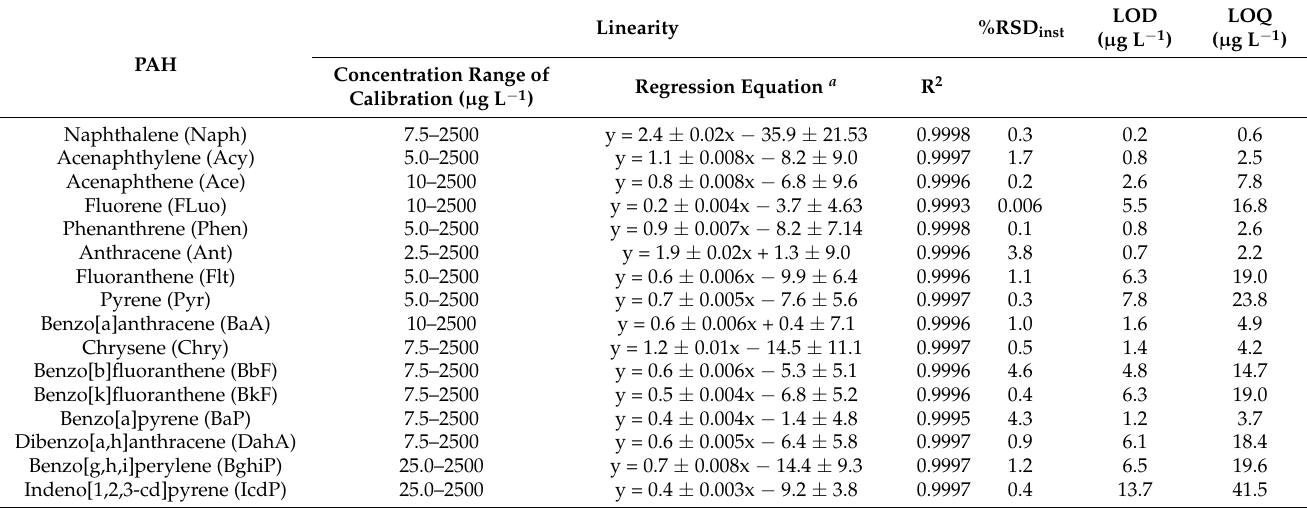
Table 2. Linear range, regression equation, coefficient of determination (R 2 ), instrumental repeatabil- ity expressed in terms of percent relative standard deviation (%RSD inst ), and instrumental limit of detection (LOD) and quantification (LOQ).